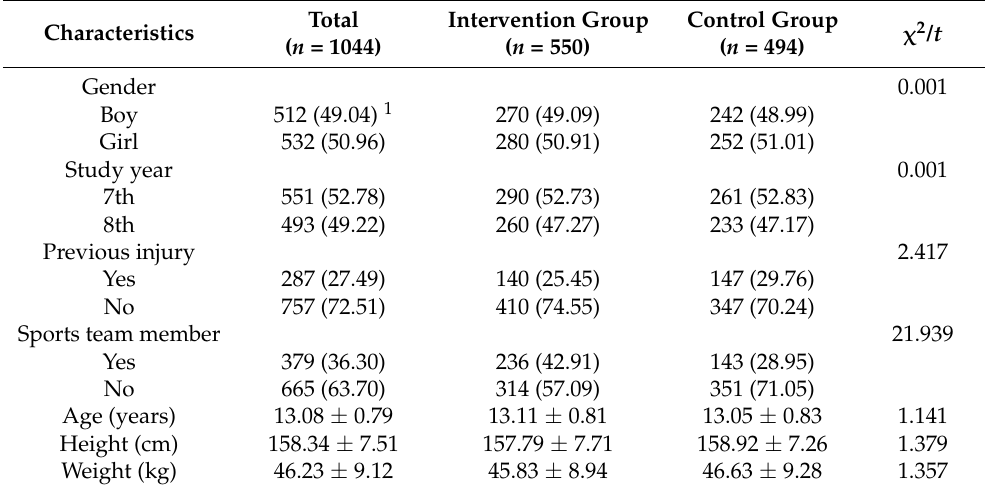
Table 2. Baseline characteristics of students in intervention and control groups.